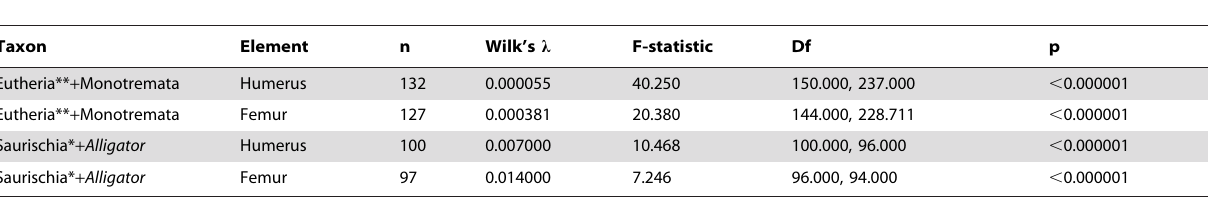
Table 1. MANOVA of partial warp scores which collectively describe the shape of the humerus and femur in the